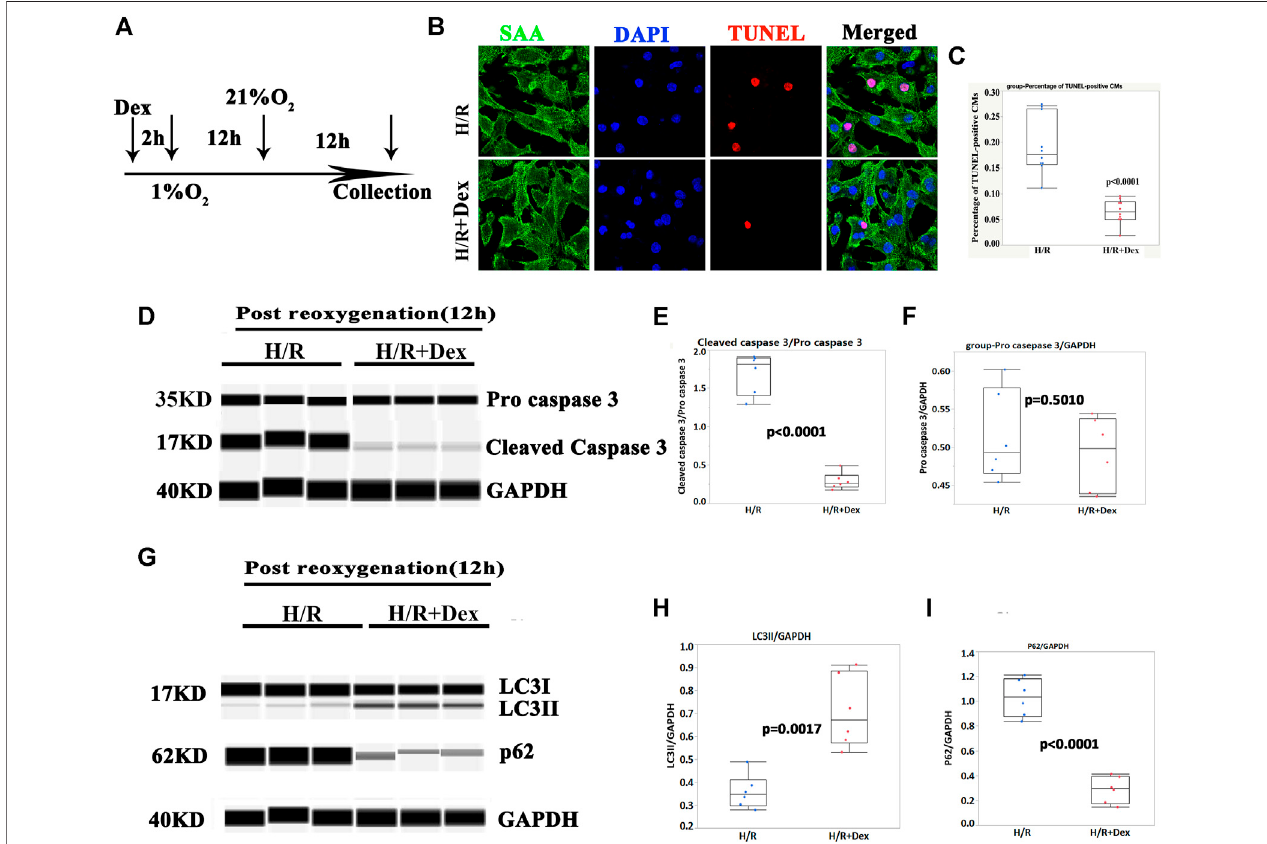
FIGURE 2 | Dex protected human iPSC-CMs from apoptosis and was associated with autophagy. (A) Timelines of the Dex, hypoxia (1% O 2 ) and reoxygenation (21% O 2 ) treatments. (B) Representative immuno fl uorescence images of the iPSC-CM pretreated with Dex. Blue (DAPI), red (TUNEL), and green (sarcomeric α - actin, SAA). (C) Quanti fi cation oftheTUNEL-positive cells. N (cid:2) 10 fi elds from threeindependent experiments. (D) Representative pro-cleaved caspase 3Wes blot oftheiPSC- CMspretreatedwithDexatthetimeofpost-reoxygenation(12 h). (E) Quanti fi cationofthecleavedcaspase3relativeexpression.N (cid:2) 6replicates. (F) Quanti fi cation ofthepro-caspase3relativeexpression.N (cid:2) 6replicates. (G) Representative LC3/p62WesblotoftheiPSC-CMs pretreatedwithDexatthetimeofpost-reoxygenation (12 h). (H) Quanti fi cation of the LC3II relative expression. N (cid:2) 6 replicates. (I) Quanti fi cation of the p62 relative expression. N (cid:2) 6